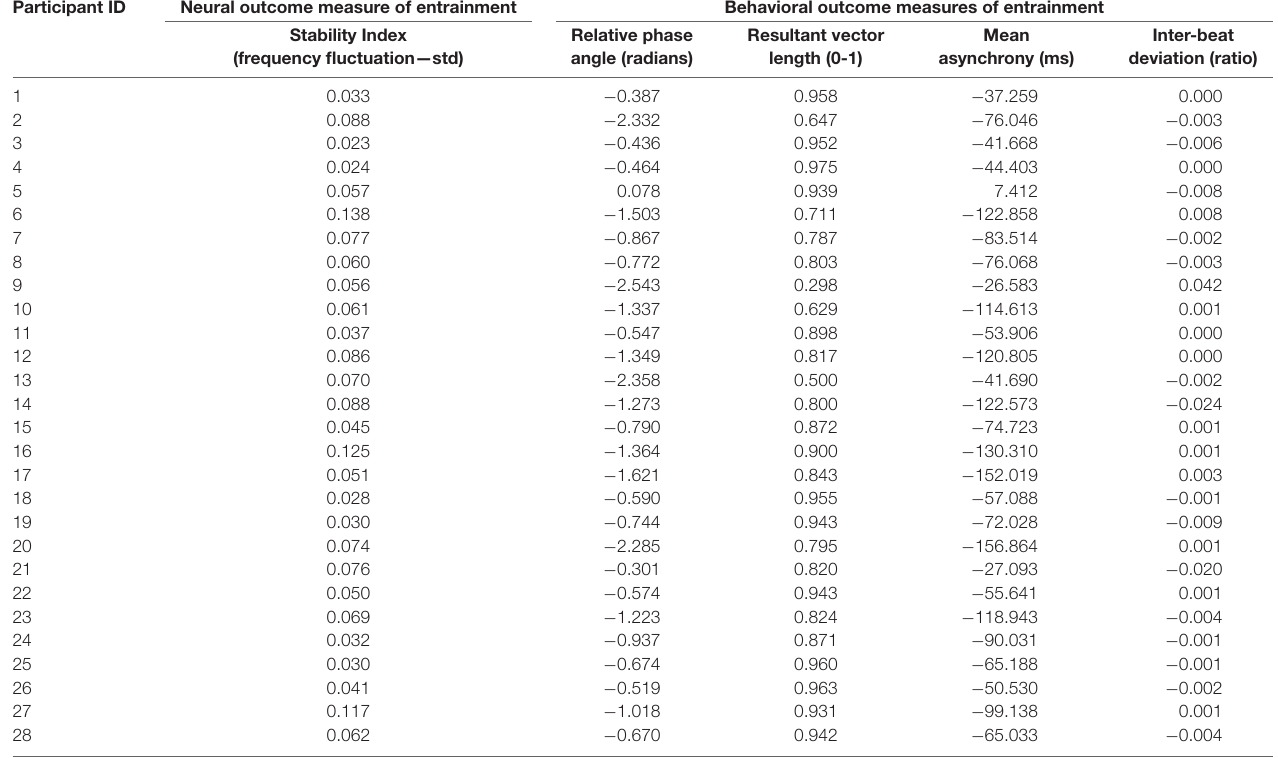
TABLE 1 | The results of neural and behavioral outcome measures of entrainment per participant. Participant ID